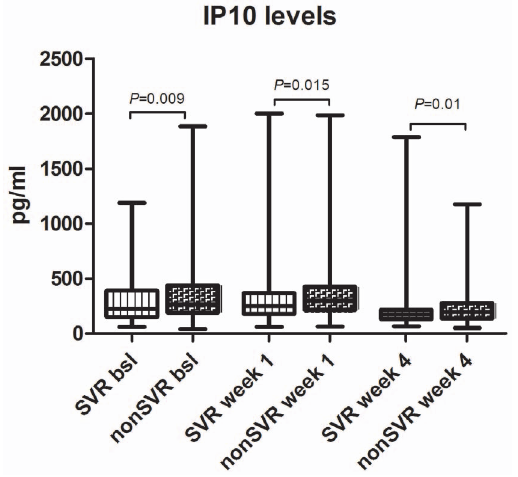
Figure 2. High cholesterol- and low gGT- levels associate with achievement of SVR and ETR.